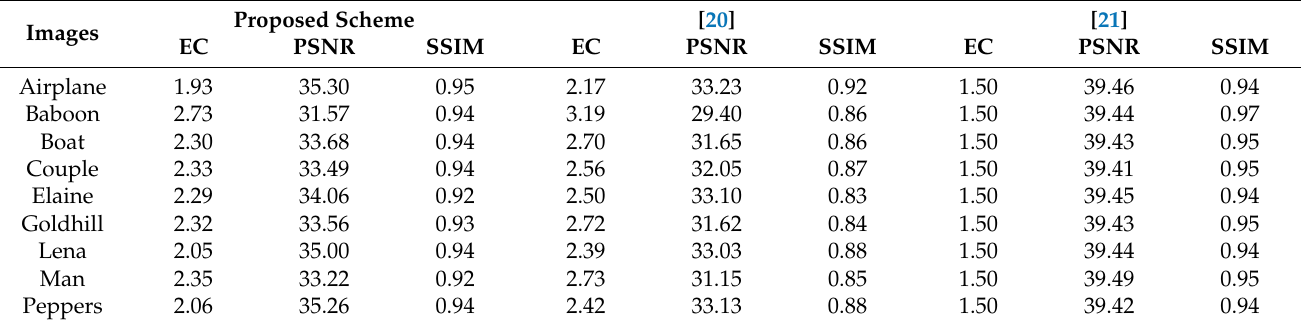
Table 1. Comparison of PSNR, SSIM and EC with related